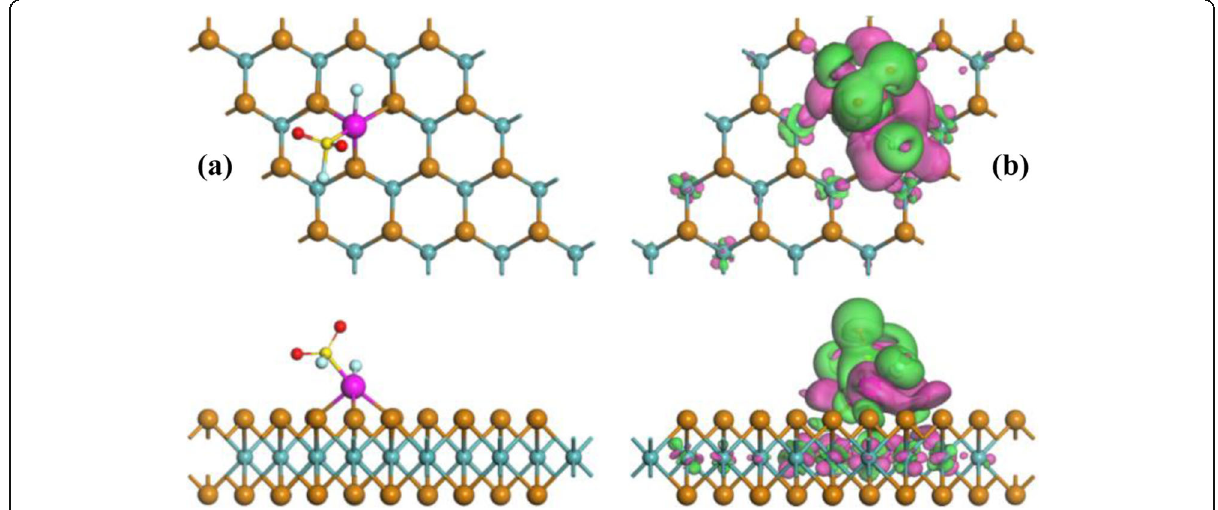
Fig. 5 Same as Fig. 3 but for Rh-MoTe 2 /SO 2 F 2